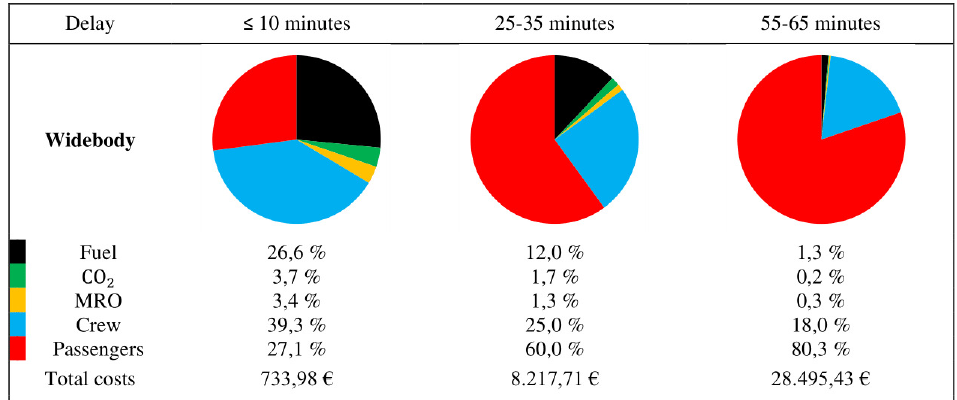
Figure 3. Share of reactionary delay costs components for a widebody aircraft in the high scenario, depending on the amount of reactionary delay ( D react.